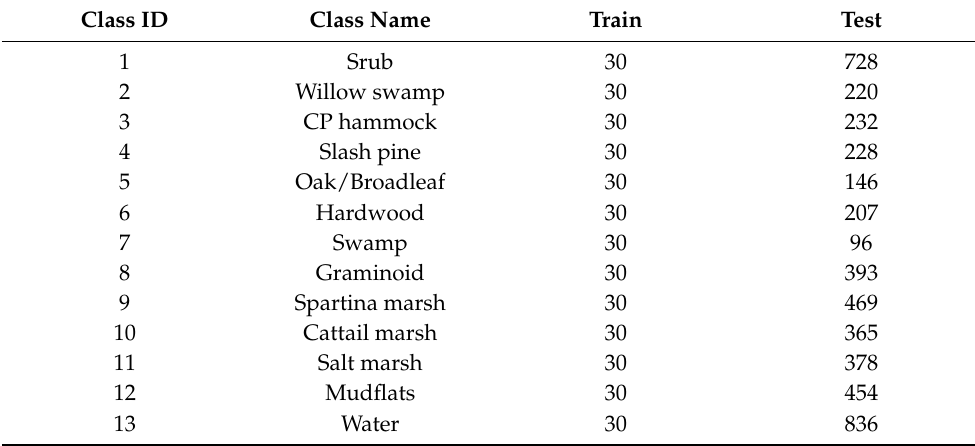
Figure 9. Kennedy Space Center. ( a ) False-color image. ( b ) Ground-truth map. Table 3. Number of training and test sets for the Kennedy Space Center